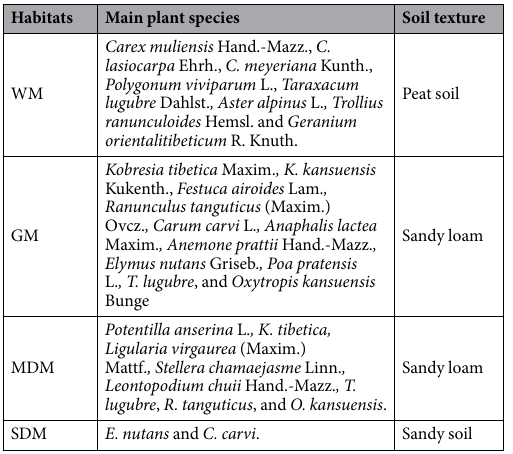
Table 1. The main plant species and soil textures of the four habitats in Zoigê Wetland. WM: Wet meadow; GM: Grassland meadow; MDM: Moderately degraded meadow; SDM: Severely degraded